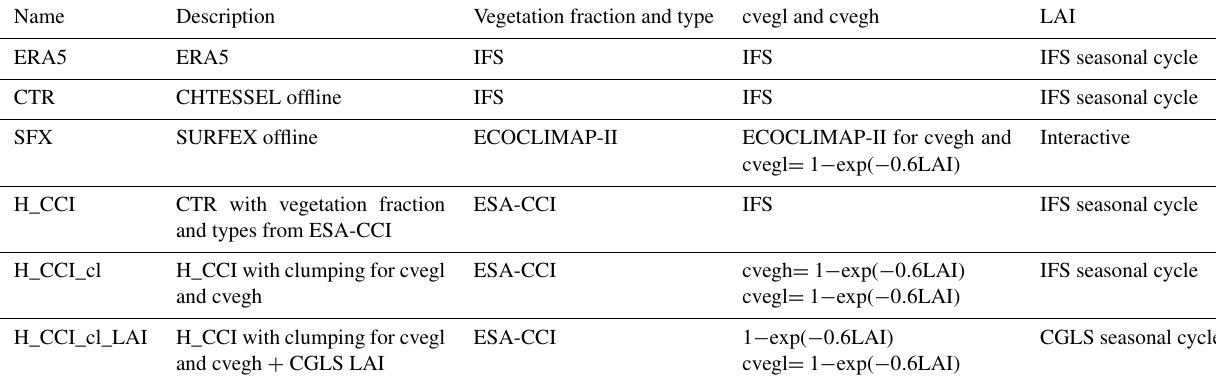
Table 1. List of simulations considered in the present study.